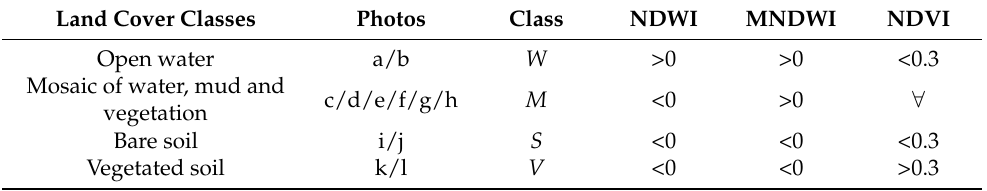
Table 3. Rule-based classification method for the mapping of the four land cover classes. Land Cover